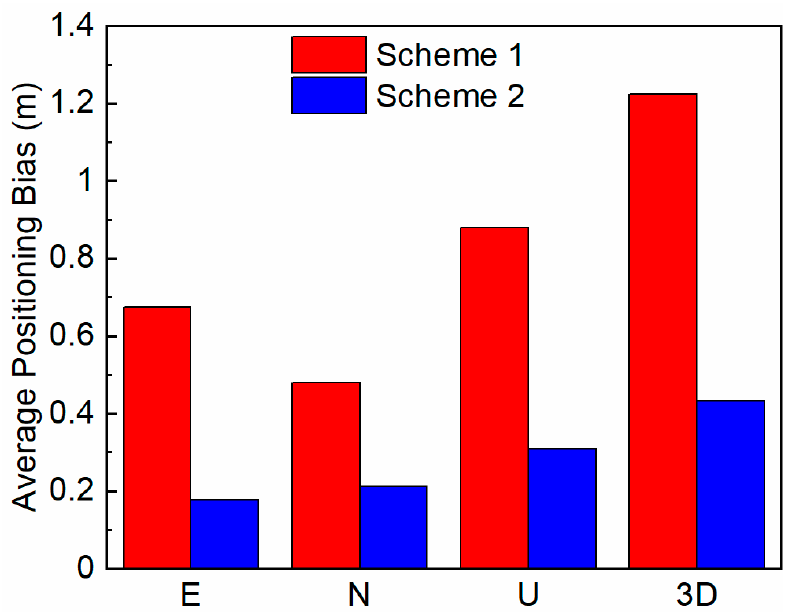
Figure 14. Average value of real-time PPP biases by using ultra-rapid precise products.